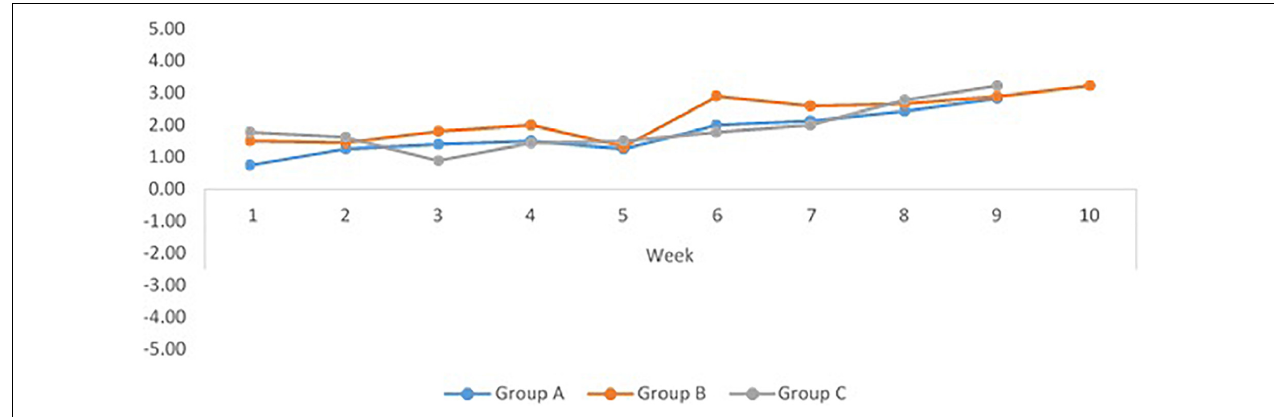
FIGURE 1 | Progression of global cohesiveness across the intervention programme (weeks 1–10), for each singing group (negative scores indicate fragmentation; positive scores indicate cohesiveness).